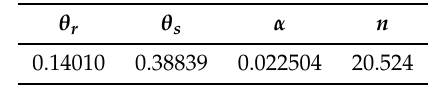
Table 2. Van Genutchen Constants for the Experimental